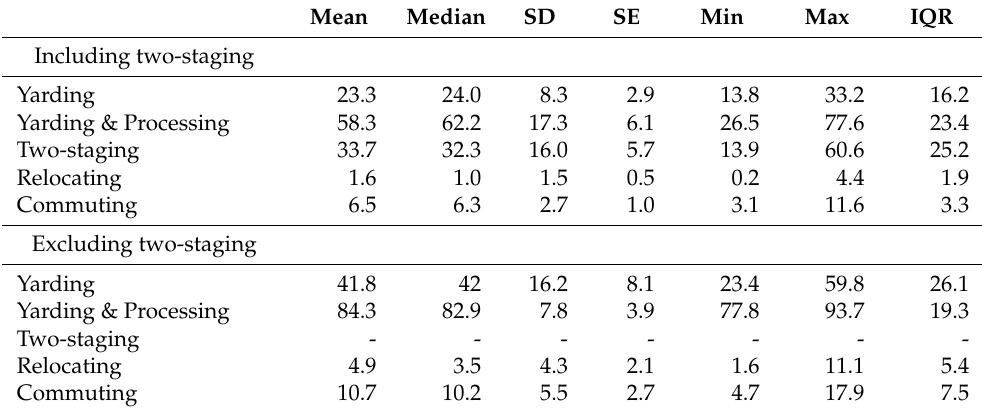
Figure 2. Breakdown of diesel fuel consumption by main task—grand totals. Table 3. Percent breakdown of total diesel fuel consumption among the main tasks (n = 12).